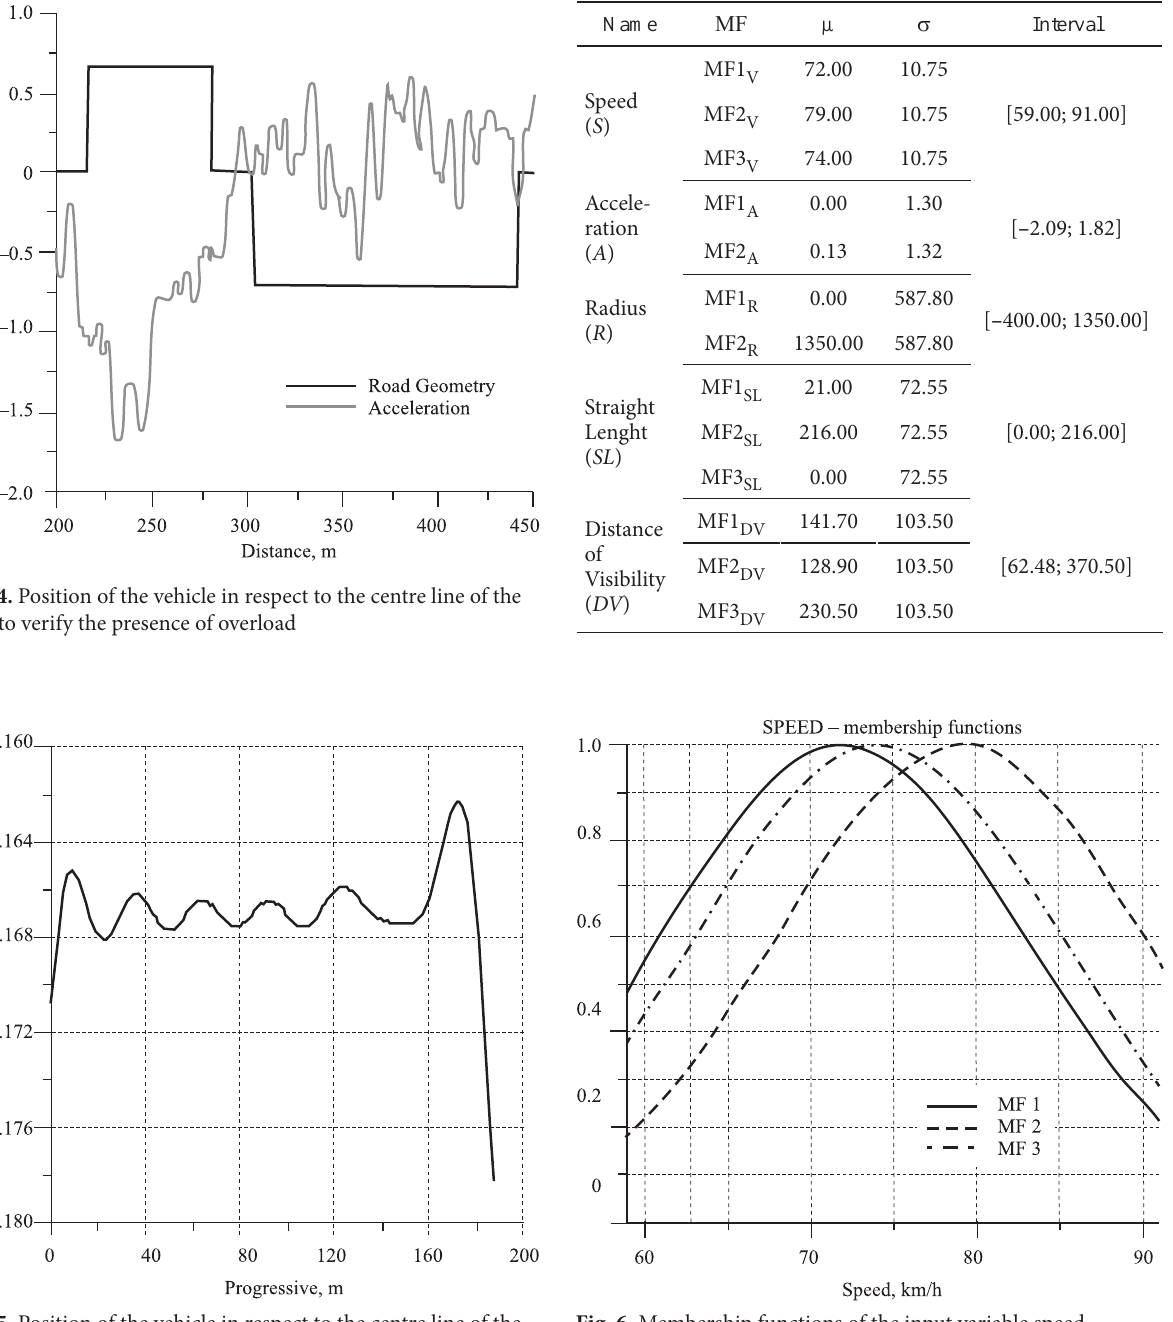
Fig. 5. Position of the vehicle in respect to the centre line of the lane to verify the presence of under load